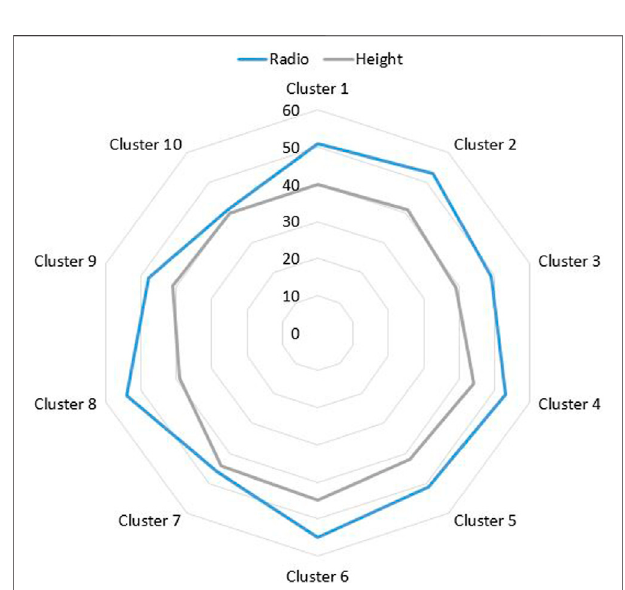
FIGURE 6 | Height and radius dimensions representation of the characterized plants.